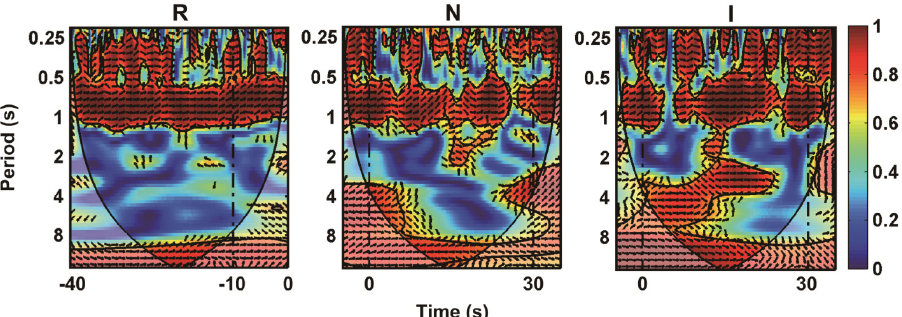
Fig. 4. WTC between the HbO 2 signal from channel 5 and channel 13 of a participant. R, rest period; N, neutral task; I, Incongruent task. Black dotted lines at 0 s indicate start of tasks. We choose time band between 0 and 30 s to calculate the average coherence value for task blocks, and (cid:2) 40 to (cid:2) 10 s for rest period.